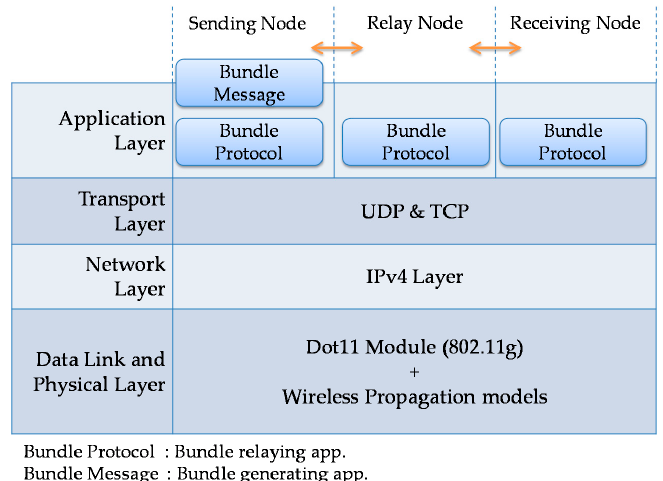
Figure 17. Protocol stack used in the Scenargie simulator [15].